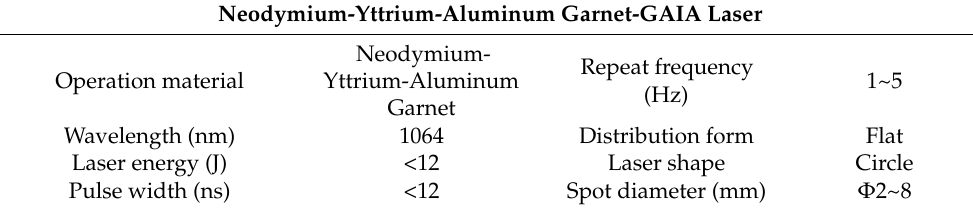
Table 1. Work parameters of the laser